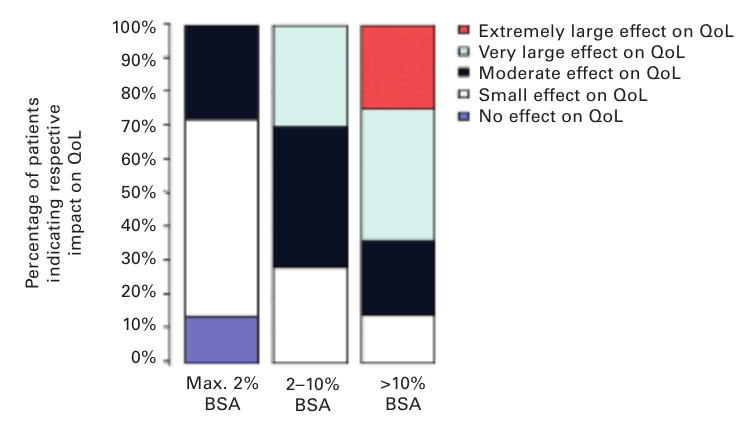
Relation between Disease severity and impact on quality of life.